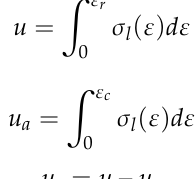
Figure 2. Calculation of bursting energy index.